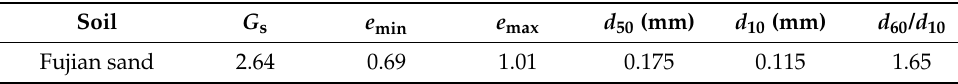
Figure 2. Scanning electron microscope images of the sand particles (0.1~0.25 mm). Table 1. Physical properties of the Fujian